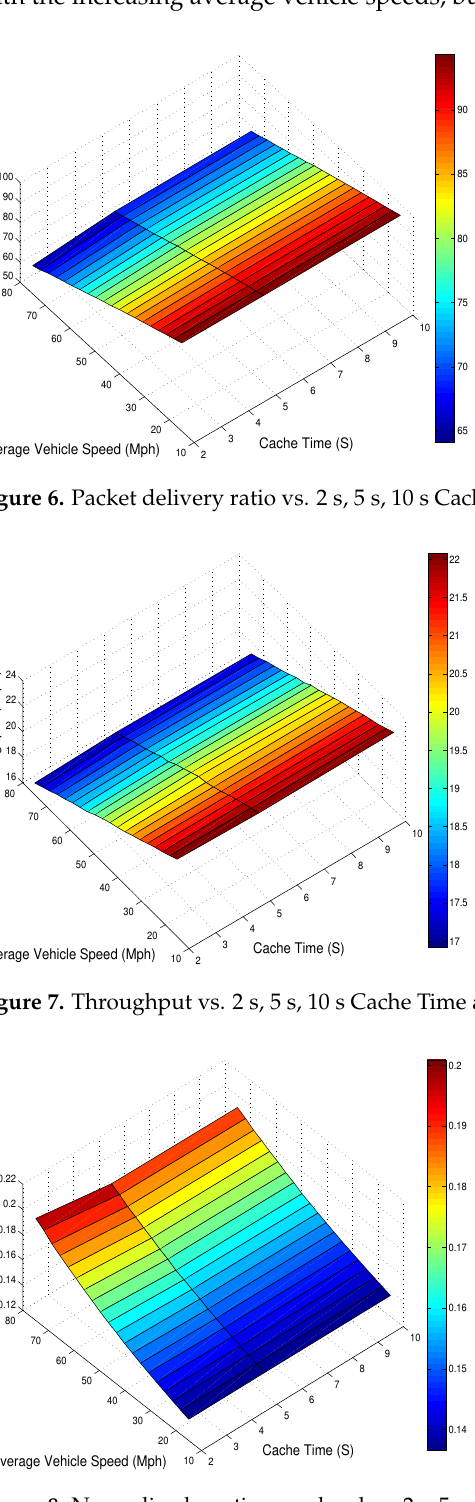
delay is increased by the increased average vehicle speeds and increased cache time.